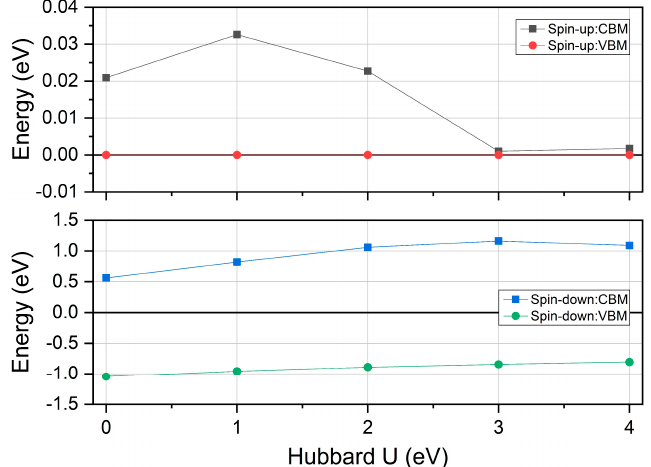
Figure 3. The calculated conduction band minimum (CBM) and valence band maximum (VBM) in both spin directions under different Hubbard U values for the half Heusler compound MnPK.